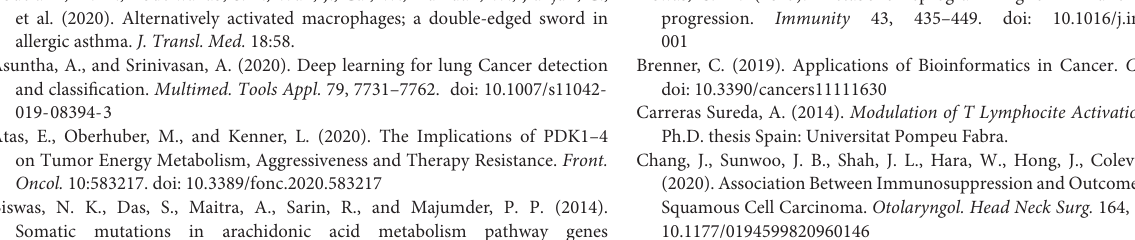
Supplementary Table 9 | The parameter settings of the SVM algorithm. Supplementary Table 10 | The parameter settings of the autoencoder algorithm.